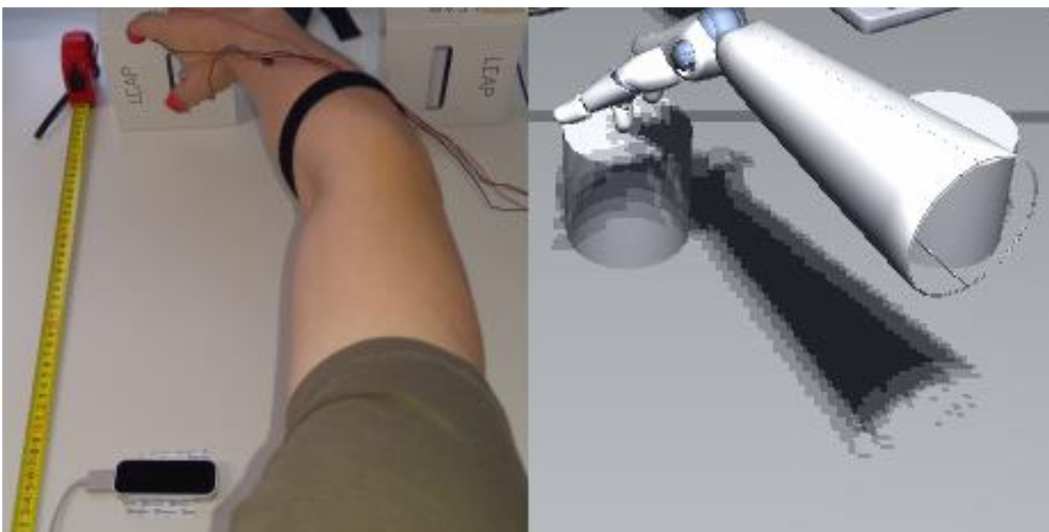
Figure 1. Real world setup and according VR impression. Cardboard boxes in the upper part of the left image served as haptic cues for the virtual pedestals representing the target locations for the bottle interaction. The central pedestal was about 50 cm away from participants, the other pedestal was 15 cm to the right and served as target location for the bottle placement. The Leap Motion © sensor was placed in front of the participants, approximately 40 cm before the central pedestal. Vibration motors were attached to the thumb and index finger tips of the participants using Velcro stripes. The motors were controlled with an Arduino Uno microcontroller (not shown in the image).